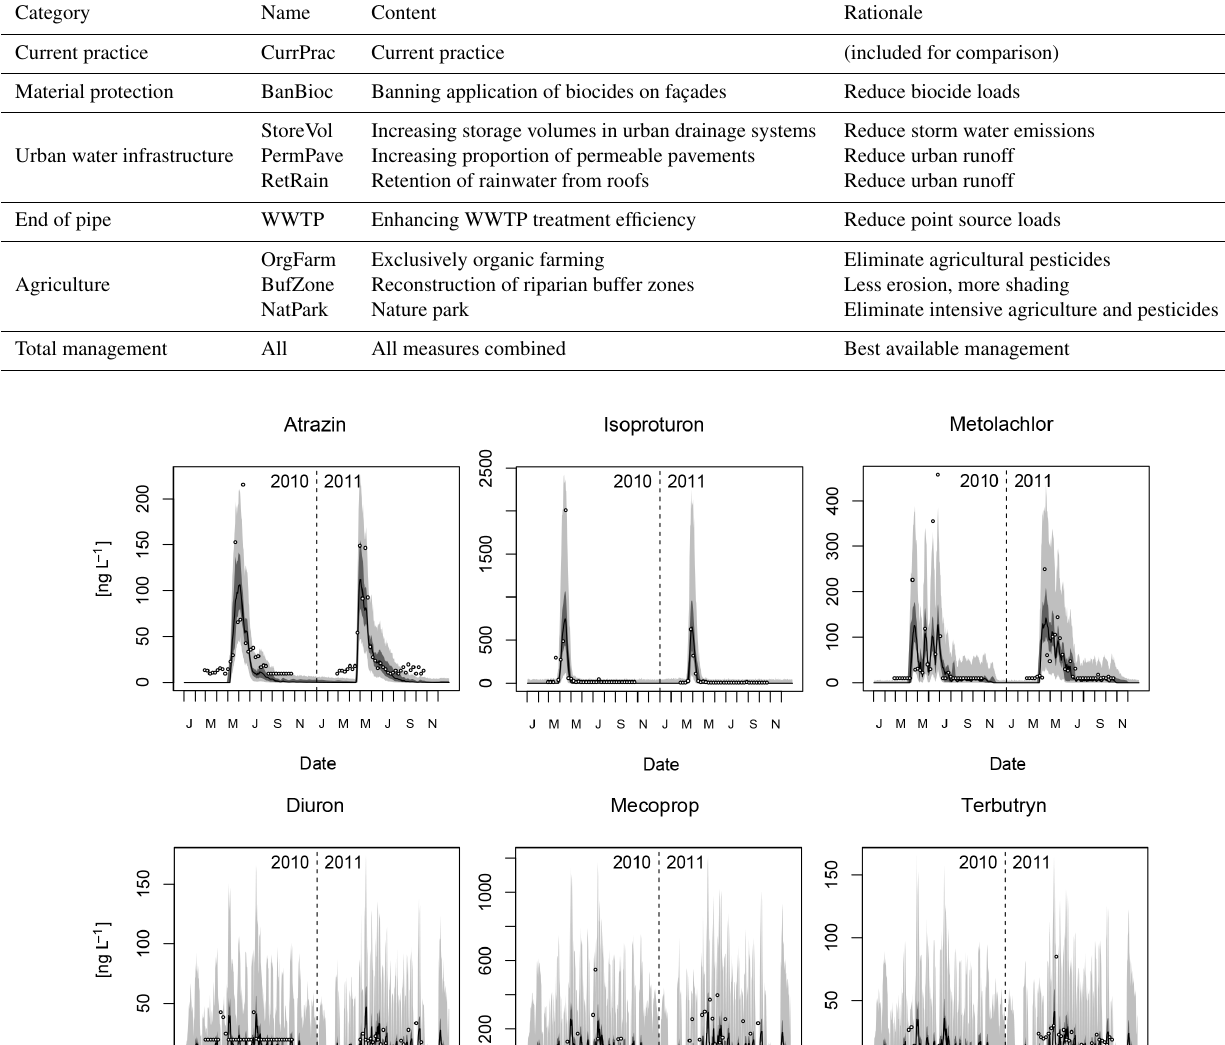
Table 3. Management alternatives.